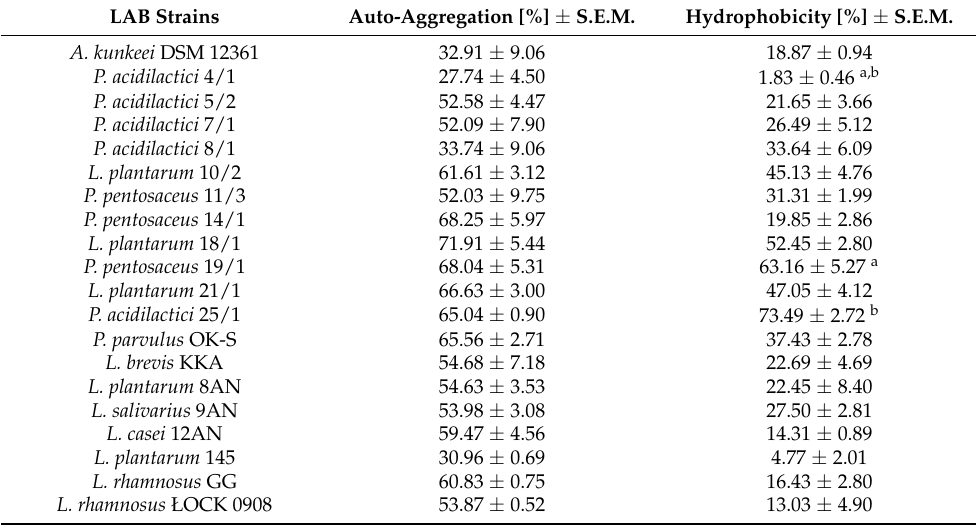
Table 1. Auto-aggregation [%] and surface hydrophobicity [%] of LAB strains. The presented results are the mean from three repeats ± standard error of the mean (S.E.M.). LAB Strains Auto-Aggregation [%] ± S.E.M. Hydrophobicity [%] ±